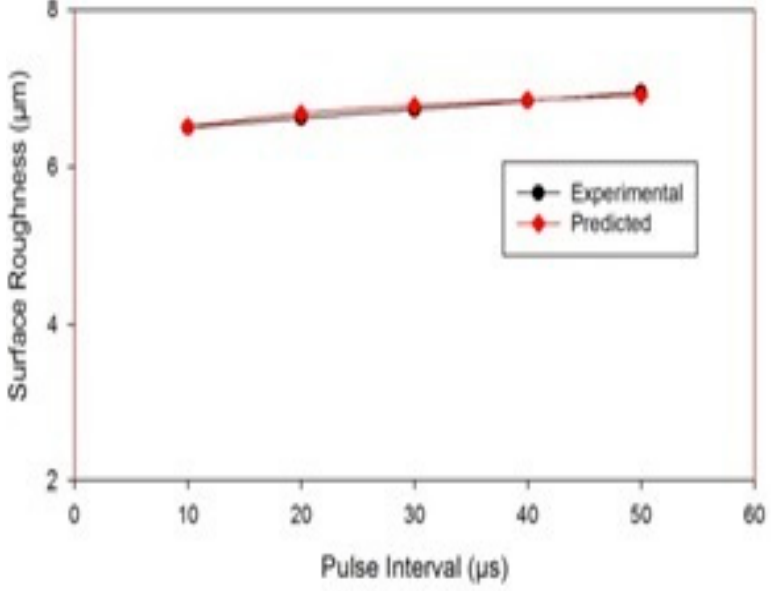
Figure 10. Variation in surface roughness with a pulse interval.